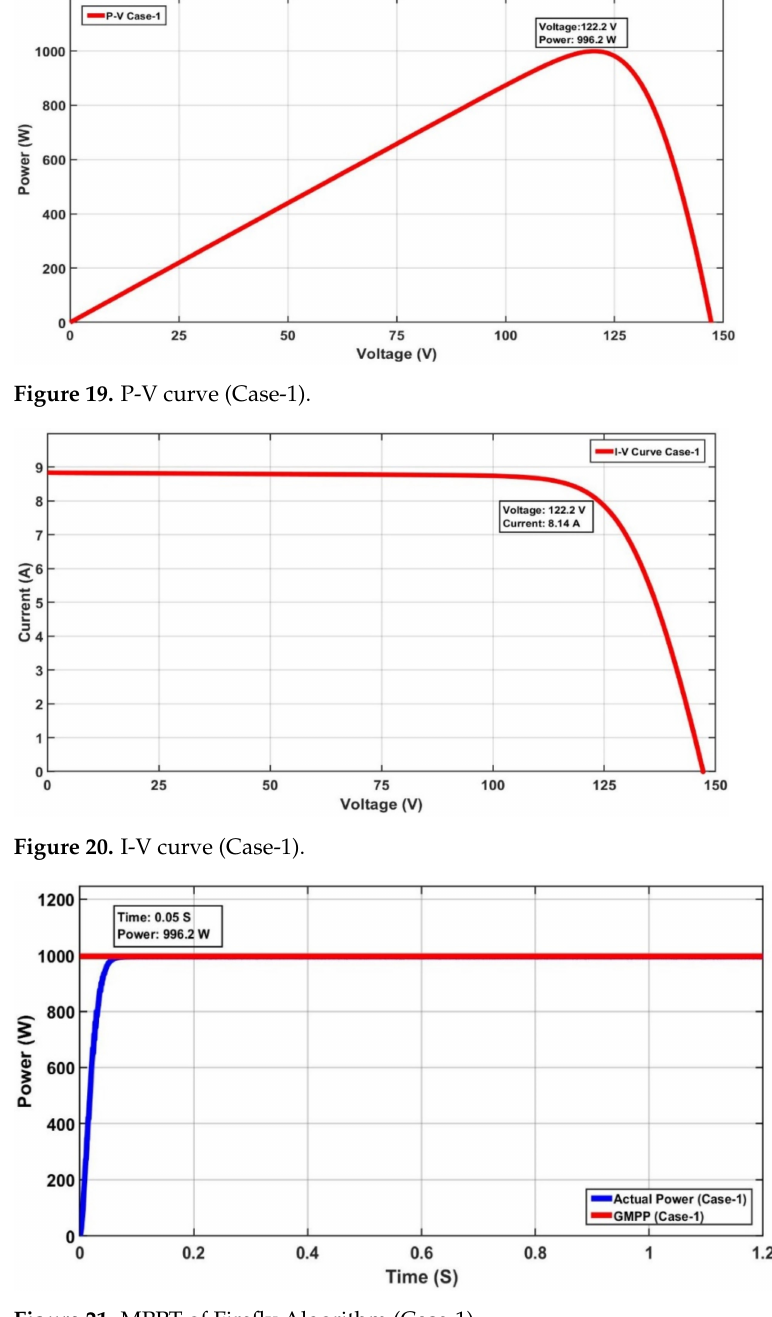
Figure 21. MPPT of Firefly Algorithm